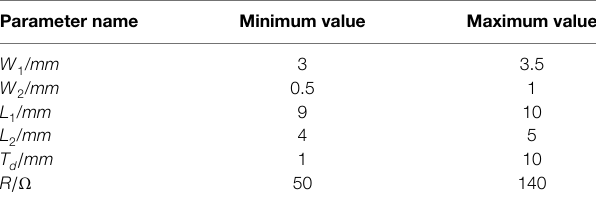
constant of PET is 3.2, and the tangent of the loss angle is